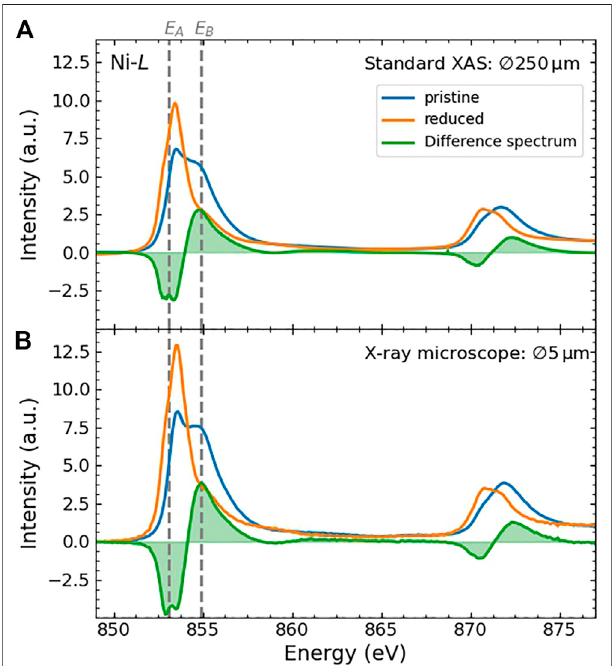
FIGURE2| XASmeasurementsacrosstheNi L -edgefromapristineand reduced PrNiO 3 thin fi lm in a standard experimental setup (A) and with an x-raymicroscope (B) .ThelattermeasurementagreeswellwithXASmeasured using a much larger beam, shown in panel (A) . From the difference spectrum (green curve), we extract two energies E A (cid:1) 853.1 eV and E B (cid:1) 854.9eV,wherethecontrastbetweenpristineandreducedisthelargest. The two energies are indicated by gray dashed lines. Subsequently, we take image scans with varying size/resolution at peak A and B on the reduced sample to check for possible oxygen inhomogeneities (see Figure 4